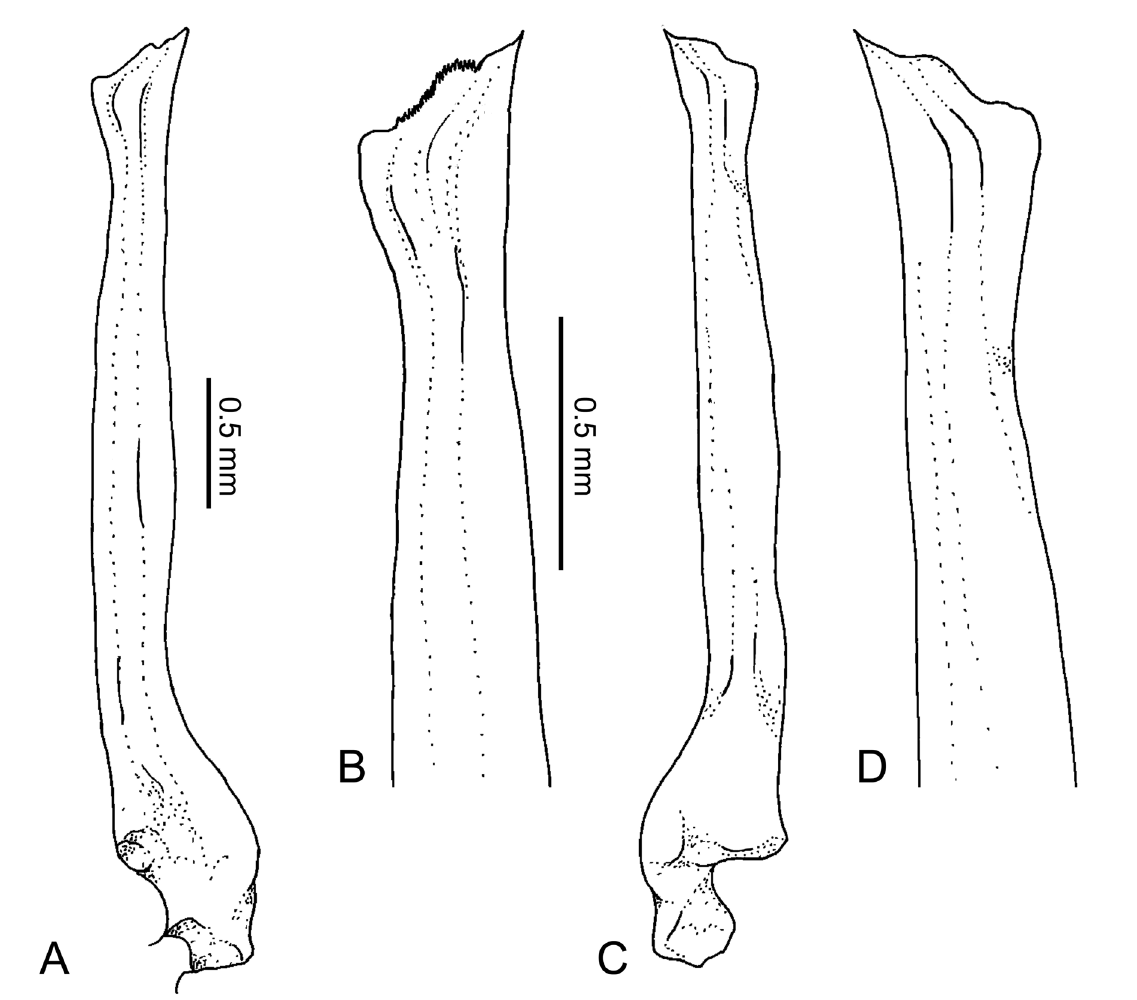
Fig. 6. Oxypleurodon leonis sp. nov., holotype, ♂ (13.5 × 9.0 mm) (NTOU), South China Sea, drawing of left G1. A . Ventral view. B . Ventral view of distal portion. C . Dorsal view. D . Dorsal view of distal